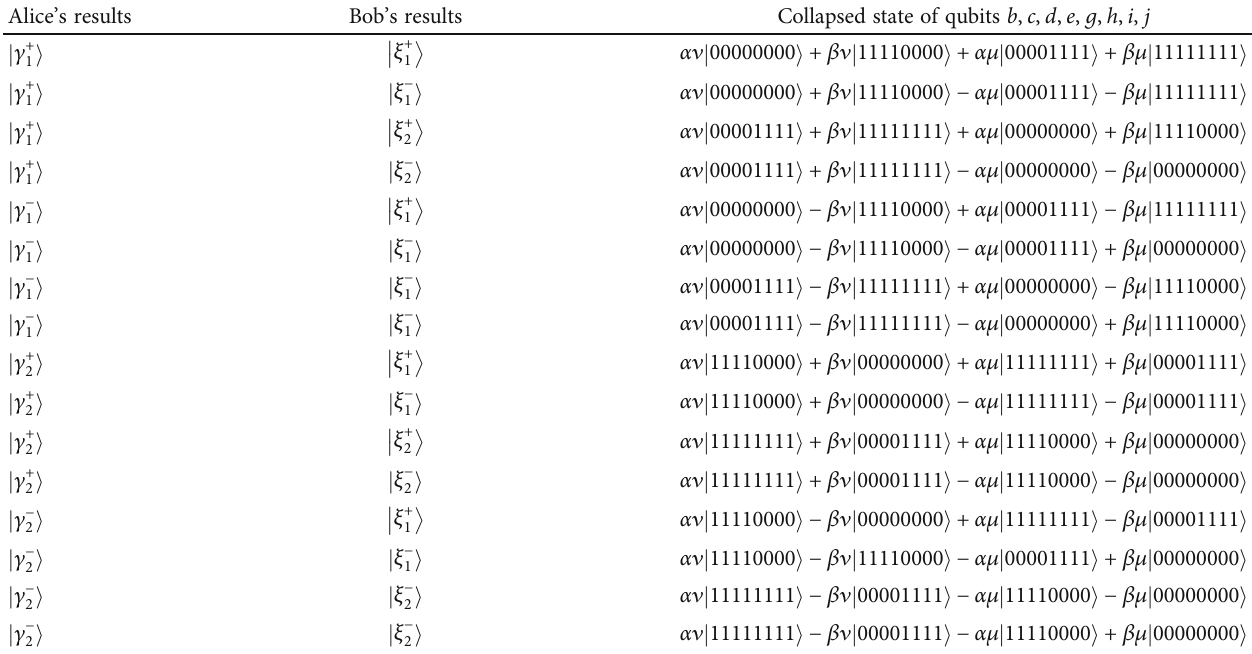
Table 1: The collapsed states of qubits b , c , d , e , g , h , i , j under Alice ’ s and Bob ’ s GHZ-state measurement. Alice ’ s results Bob ’ s results